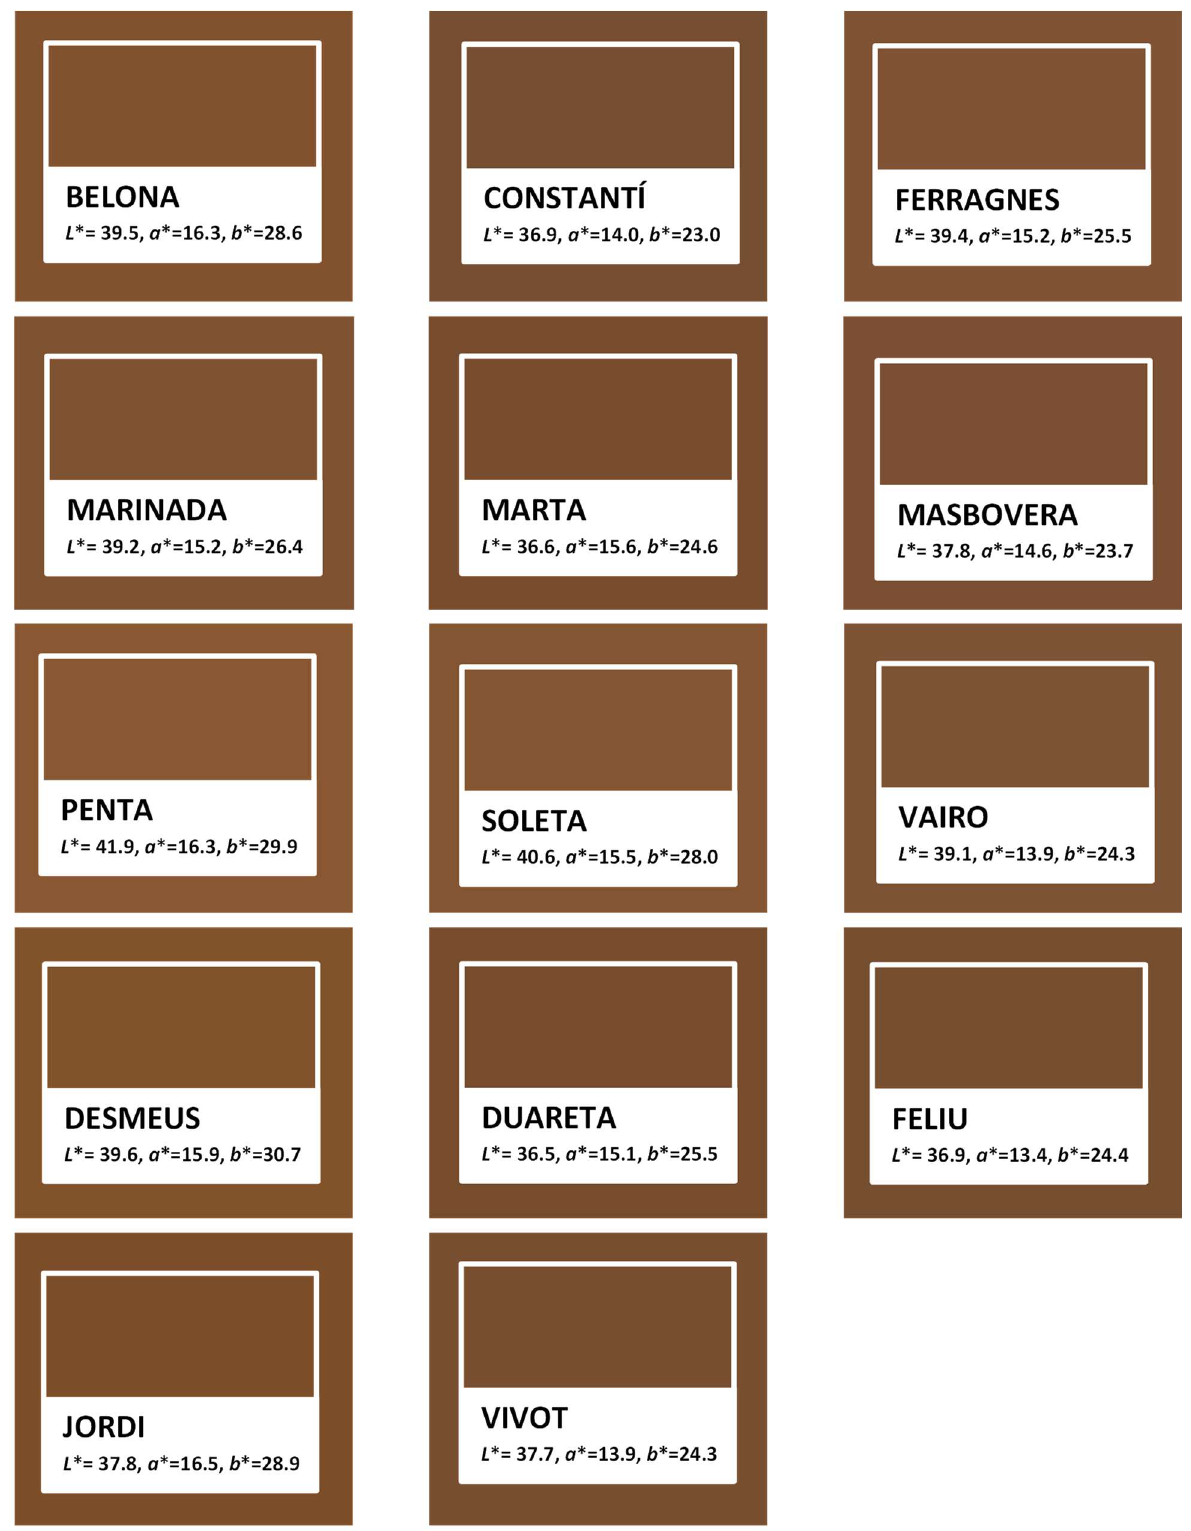
Figure 2. Pantone of each cultivar combining L* , a* , b* color coordinates values in a color